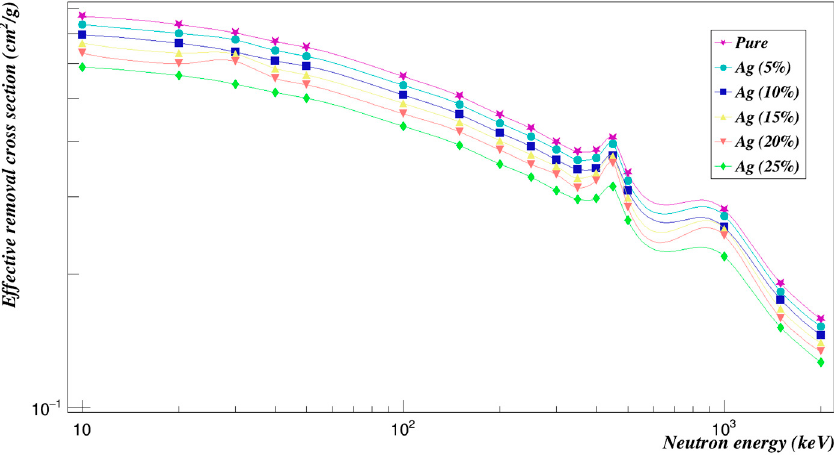
Figure 13. Neutron e ff ective removal cross sections of Polyimide doped with silver.